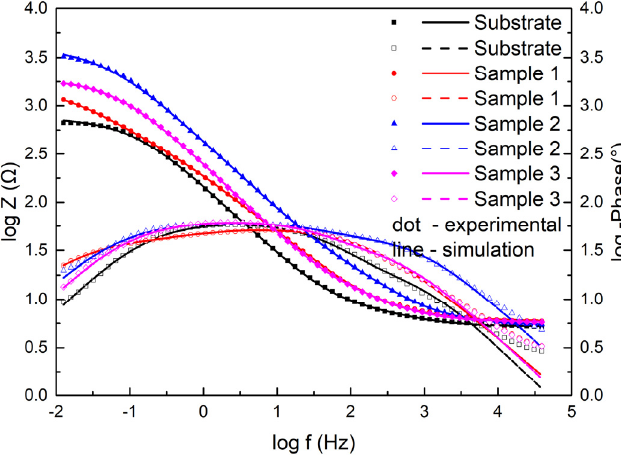
Figure 11. Bode diagrams for the substrate and cermet coatings at various laser powers.